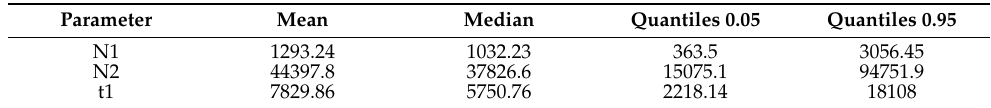
Table A5. Posterior distribution for each parameter of the best-fitted model of Campylorhynchus yucatanicus’ historical demographic changes under scenario 3 (recent bottleneck) based on a training reference table of 100K simulations and 500 RF decision trees.